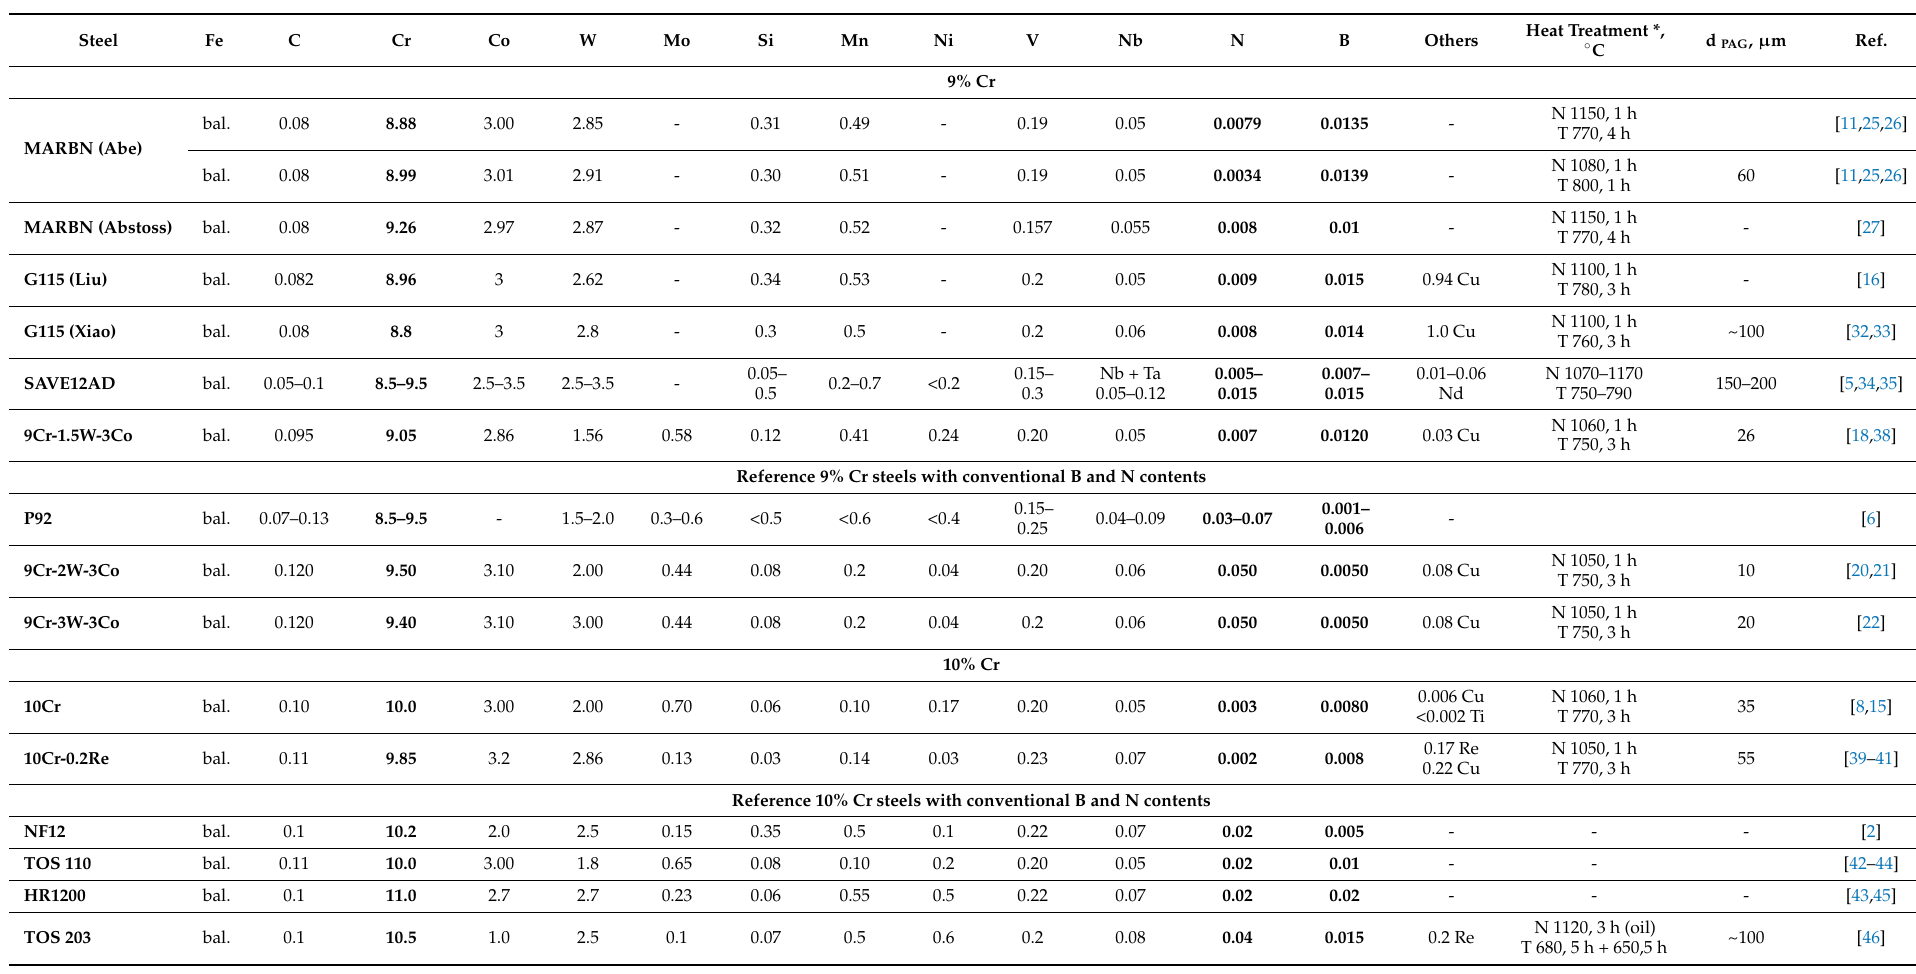
Table 1. Chemical composition of 9–12% Cr steels with high B and low N contents (in wt. %). Data are adapted from Refs.